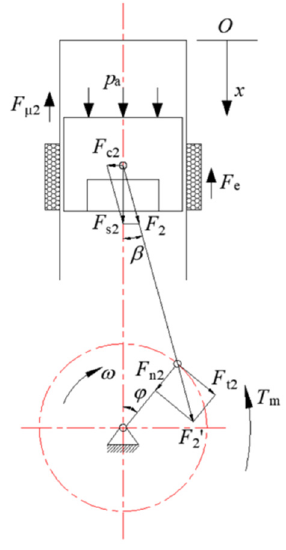
Figure 2. Sketch of force analysis under the work stroke.